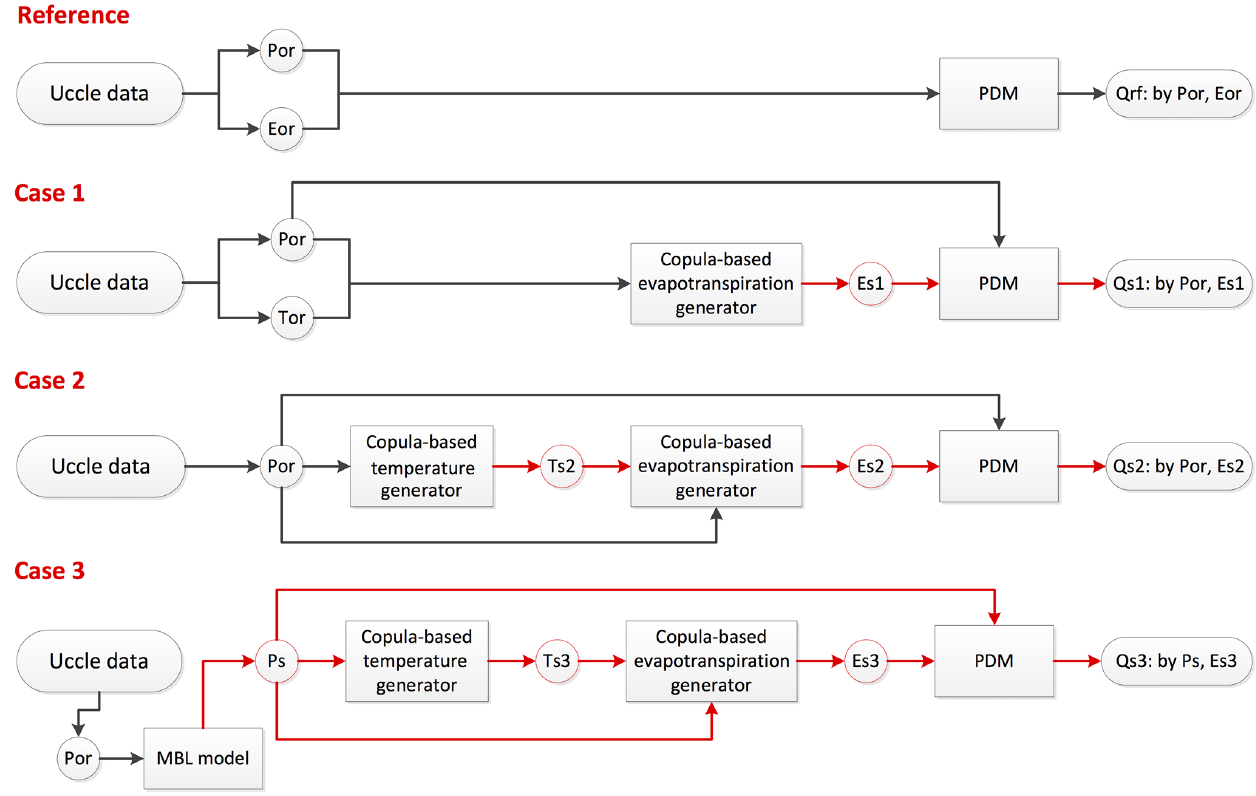
Figure 11. Different cases for discharge simulation. P or , E or and T or refer to the observed time series. P s , E s1 , E s2 , E s3 , T s2 and T s3 refer to the simulated time series (red blocks). Red arrows indicate the simulation processes related to stochastically generated time